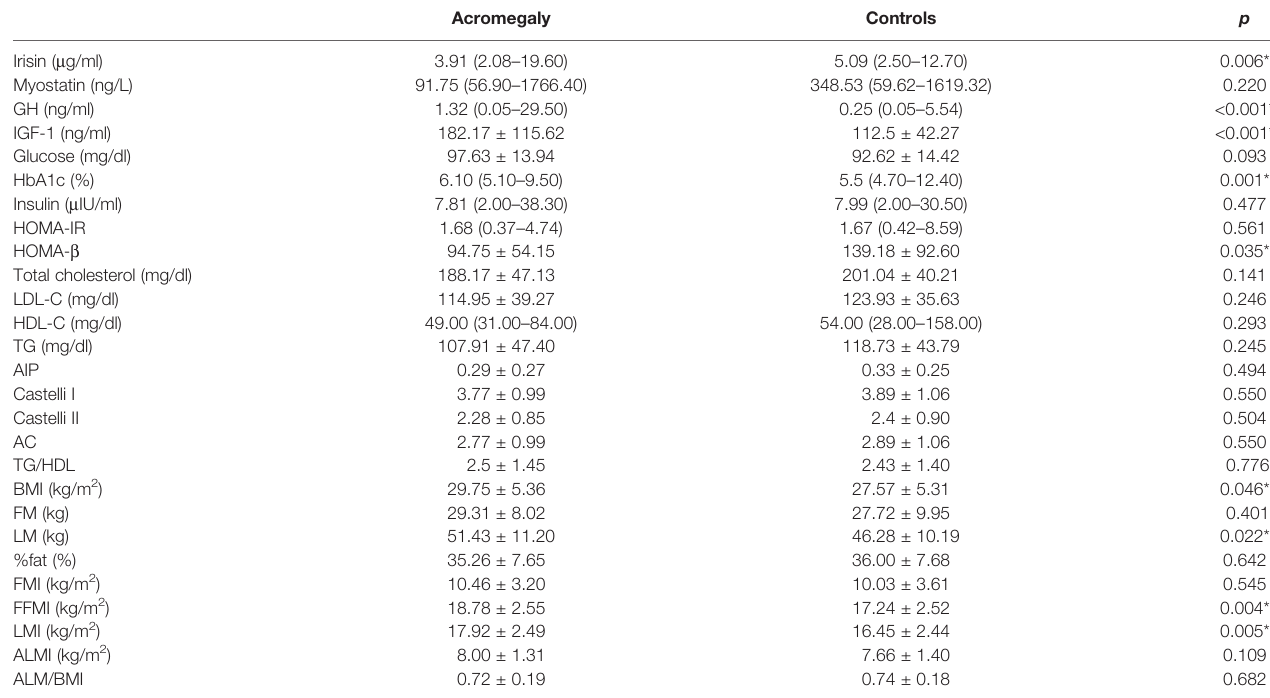
TABLE 2 | Laboratory parameters in patients with acromegaly and